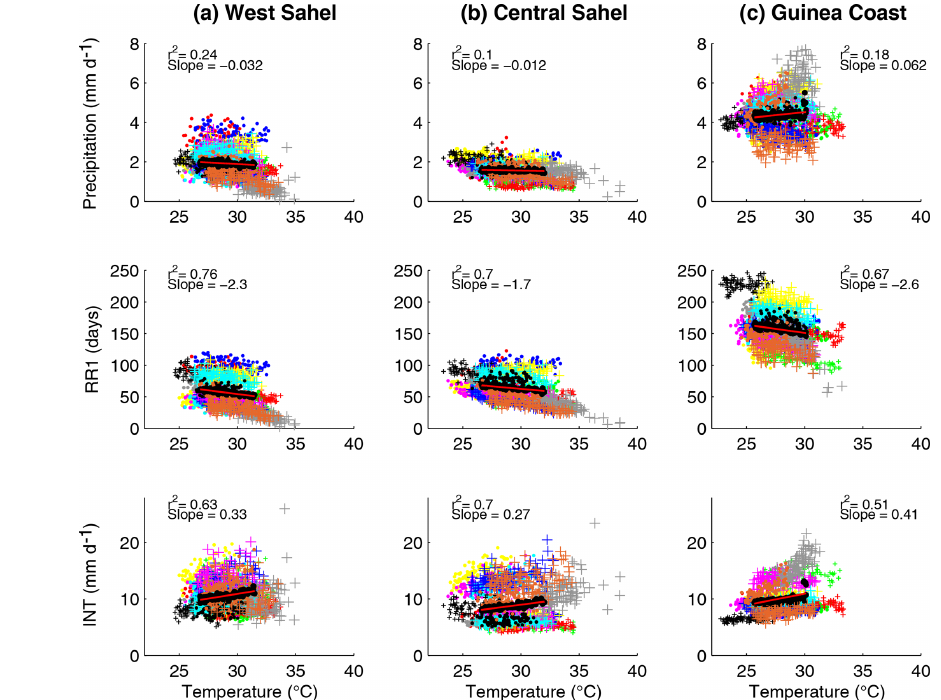
Figure 3. Annual values of mean precipitation (mmd − 1 ), RR1 (days), and INT (mmd − 1 ) ( y axis) shown against annual mean temperature ( ◦ C) ( x axis), and averaged over (a) West Sahel, (b) Central Sahel, and (c) Guinea Coast. Each color corresponds to a single simulation, as described in Table 1, and the thick black dots correspond to the multimodel mean. Also shown are the fitted regression line of the multimodel mean (red line) and the associated coefficient of determination (“ r 2 ”) and correlation